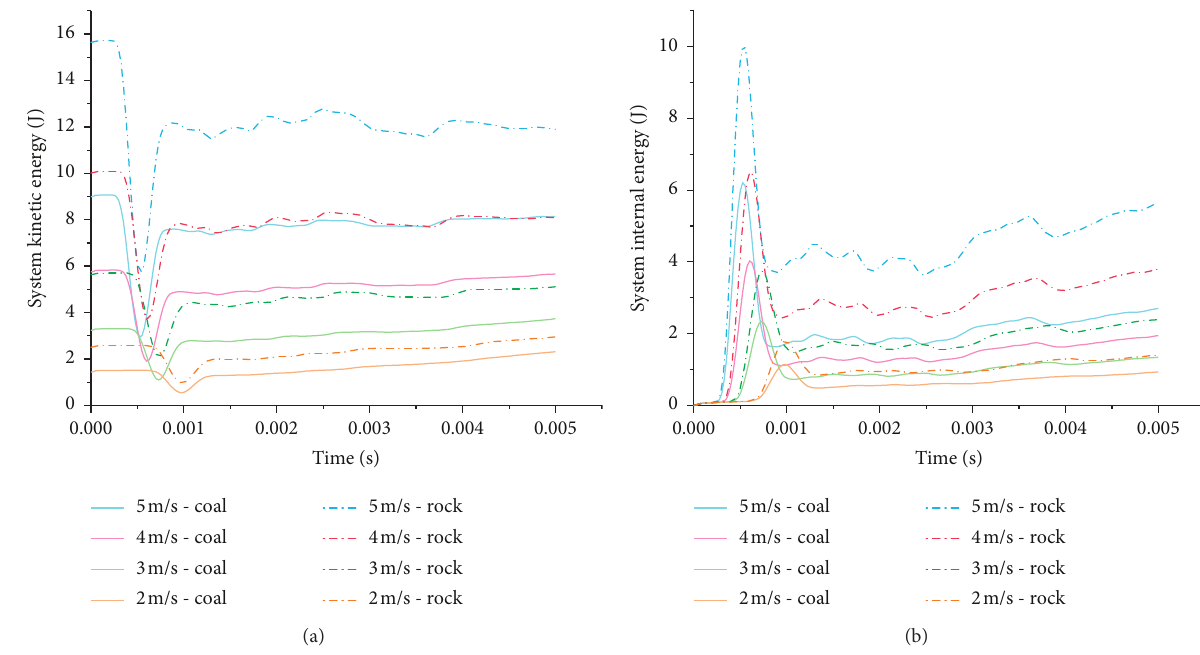
Figure 12: (a) System kinetic energy and (b) system internal energy under different impact speeds.